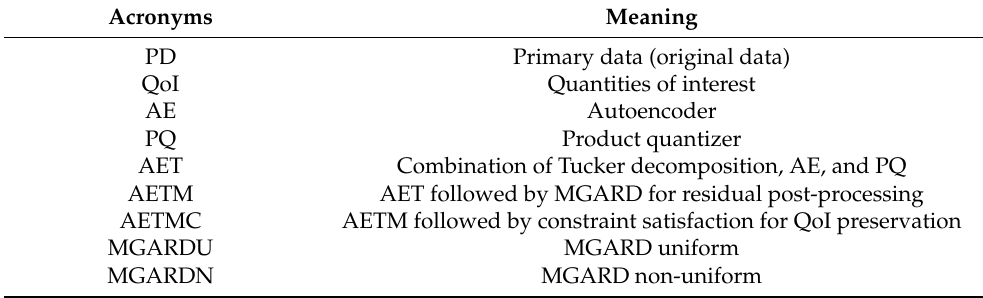
Table 1. Table of acronyms.